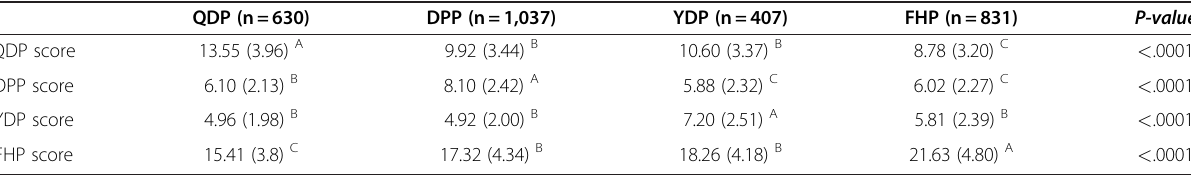
Table 3 Discriminant validity of the four